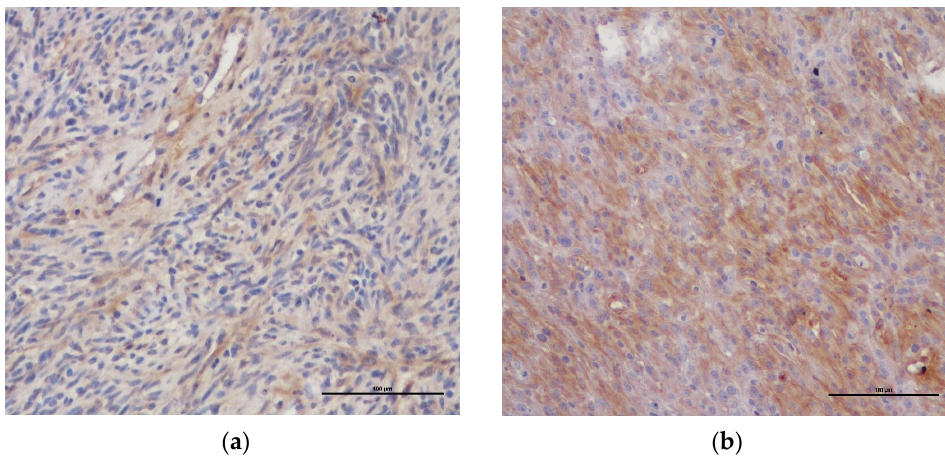
Figure 1. Immunohistochemical PDGFR- β staining in canine cutaneous PNST (×200): ( a ) MPNST with weak cytoplasmic staining in more than 25% of neoplastic cells; ( b ) MPNST with intense cytoplasmic staining in more than 25% of neoplastic cells.